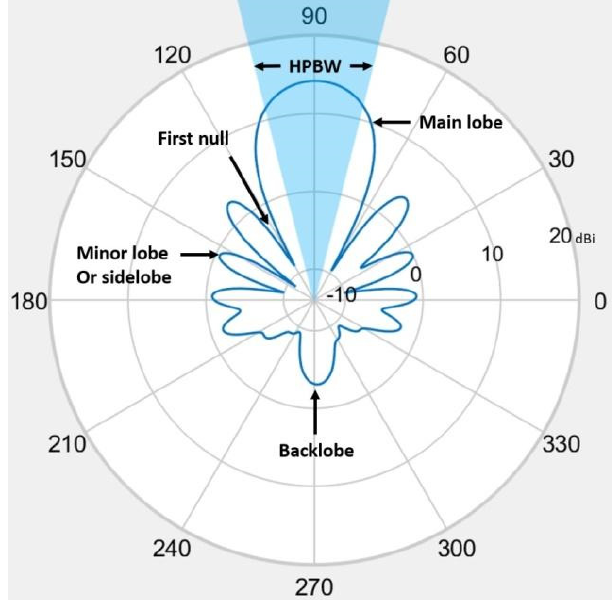
Figure 2. An antenna directive gain elevation pattern for a simple helical antenna, with beam terminology annotated. Elevation is in degrees, gain in dBi. The half-power beamwidth (HPBW) defines the plane angle at which the gain of the main beam has reduced by 50% (3 dBi).